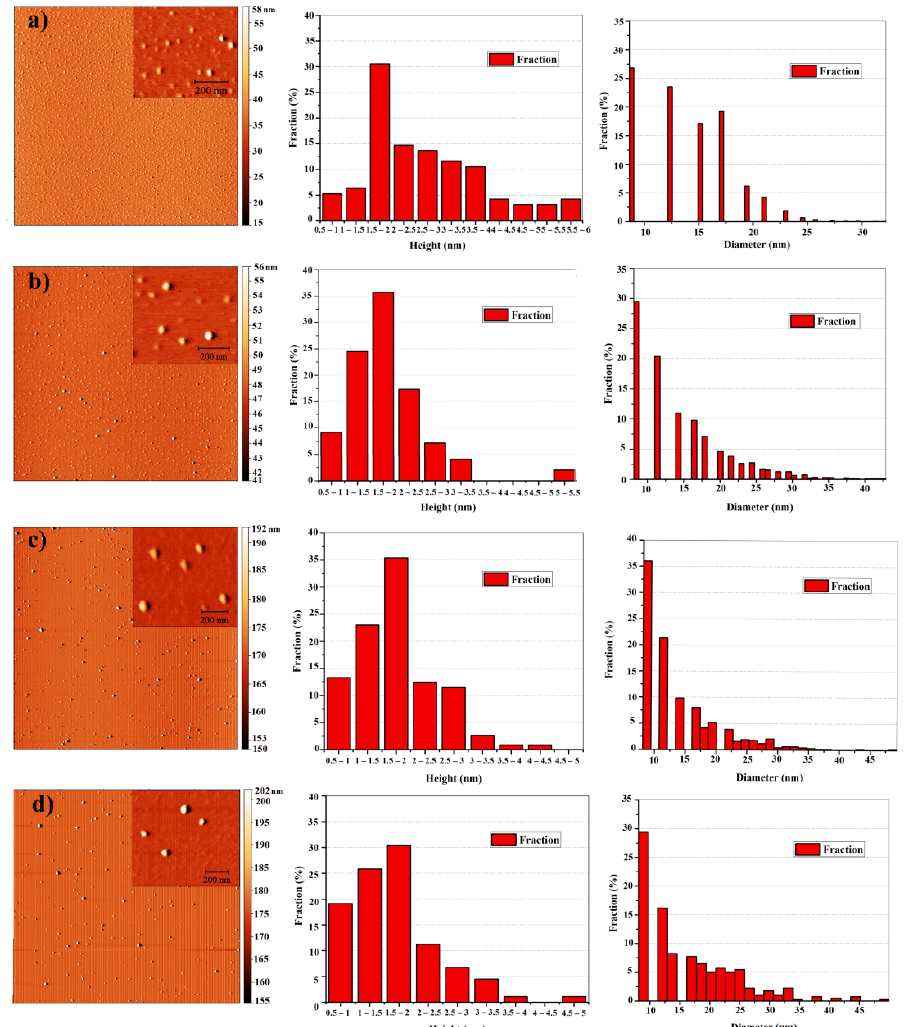
Figure 3. AFM images and histograms of height and diameter distribution for p-GQDs ( a ), GQD-cys-25 ( b ), GQDs-cys-50 ( c ), and GQD-cys-200 ( d ). Table 3. The values of the average diameter and height of GQD samples, before and after irradiation. Sample Diameter (nm) Height (nm)